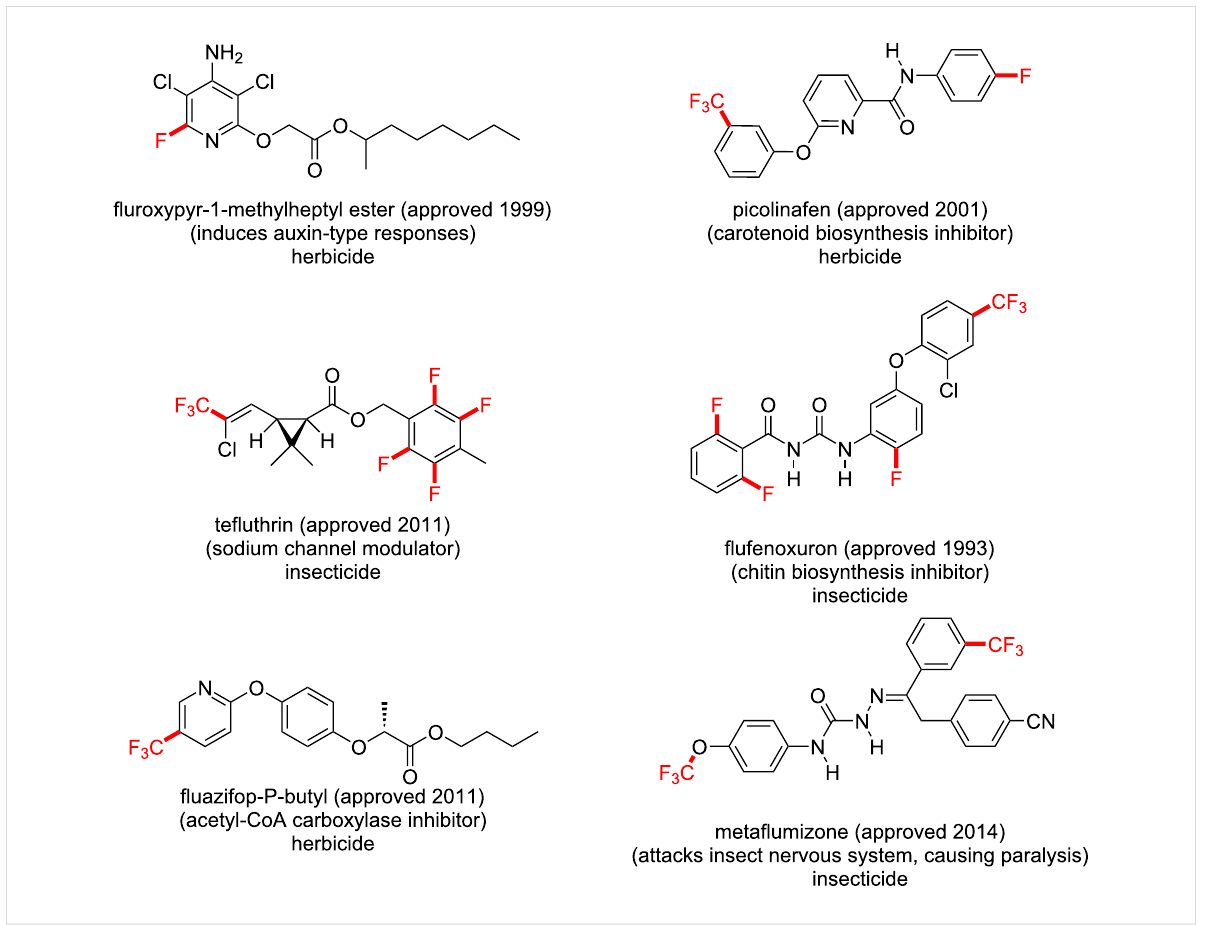
Figure 2: Fluorinated